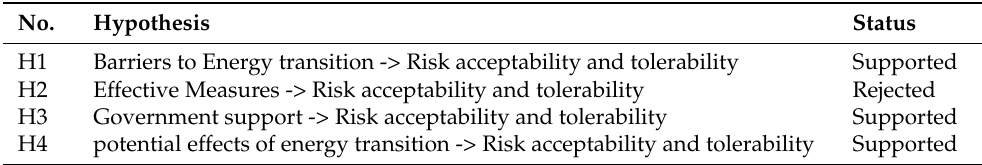
Table 5. Results of